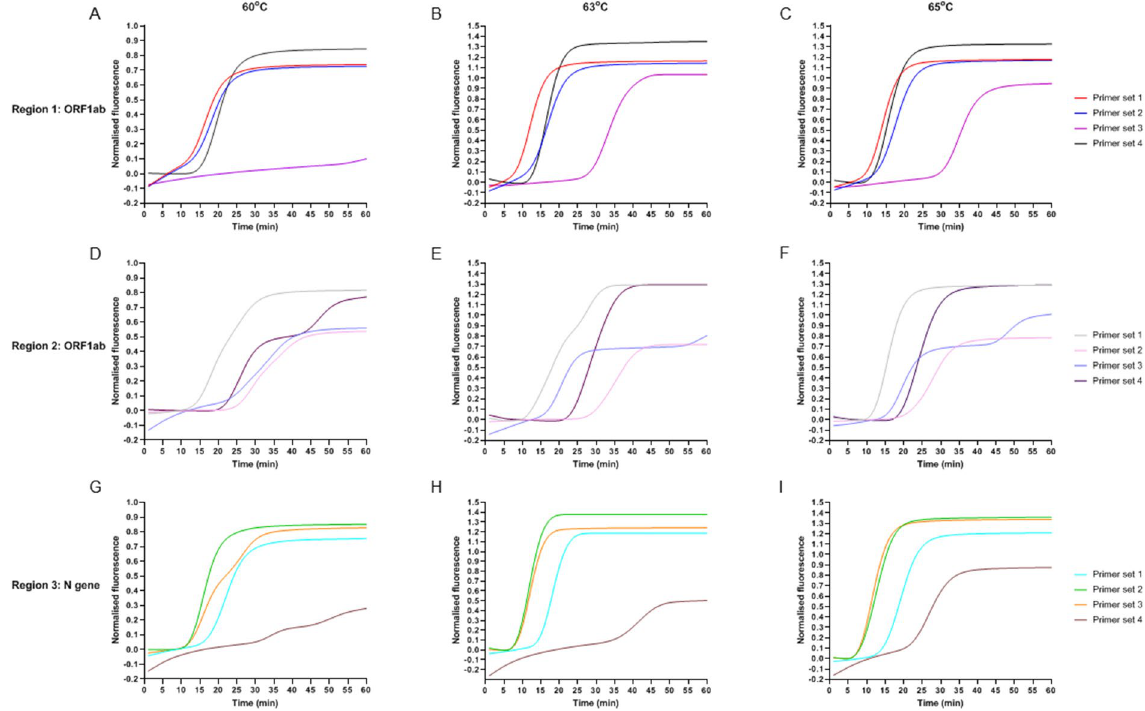
Figure 1. Initial evaluation of MCDA primer sets at 3 different isothermal amplification temperature (60 °C, 63 °C and 65 °C). Four MCDA primer sets were designed for each target region chosen. ( A–C ) Region 1 ORF1ab: 515–831 bp ( D–E ) Region 2 ORF1ab: 12,968–13,288 bp ( F–H ) Region 3 N gene: 28,345–28,647